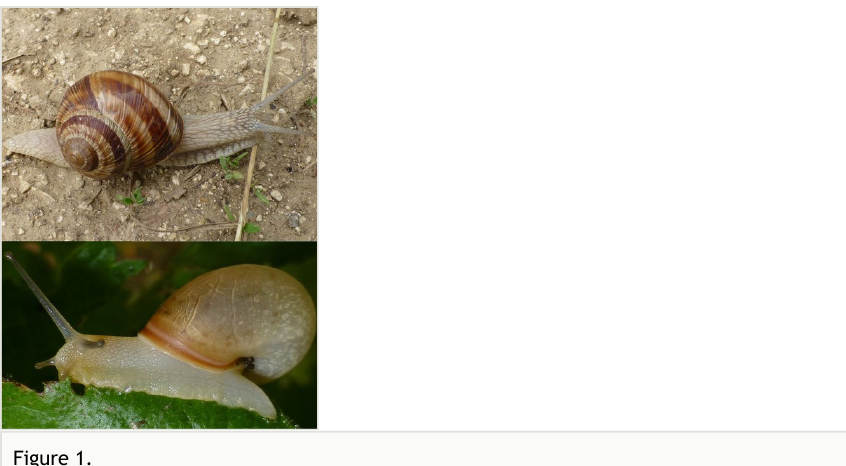
Above: Helix pomatia Linnaeus 1758 (diameter of shell 41 mm); below: Monacha carascaloides (Bourguignat 1855) (diameter of shell 16 mm), Sreburna reserve, buffer zone, meadow and